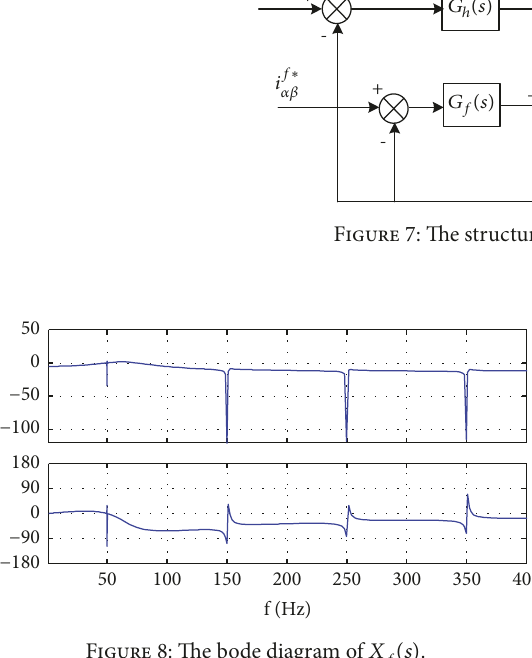
Figure 8: The bode diagram of 𝑋 𝑓 (𝑠) .